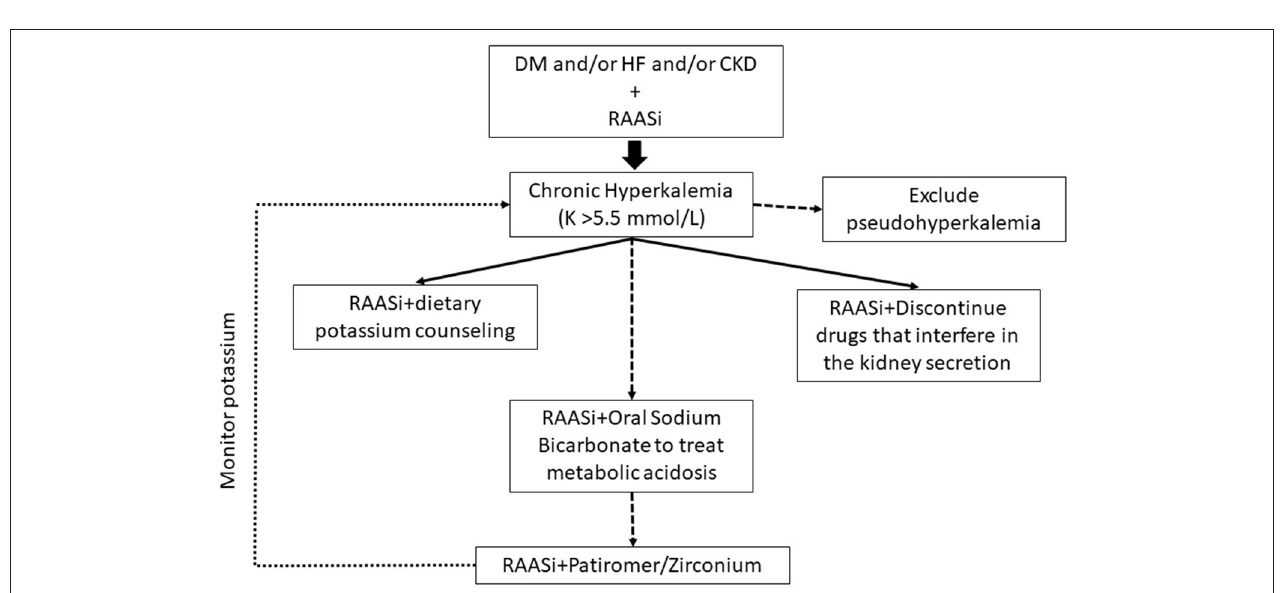
FIGURE 3 | Treatment algorithm for chronic hyperkalemia. Current recommendations regarding the management of chronic hyperkalemia (long-term elevated serum potassium) include the management of diuretics, modification of RAASi dose, treatment of metabolic acidosis with sodium bicarbonate, and removal of other hyperkalemia-causing medications. A team approach for chronic hyperkalemia, primary care physicians, nurses, pharmacists, or dietitians is optimal. The initiation of potassium binding agents should be considered in patients with chronic hyperkalemia despite optimized diuretic therapy and correction of metabolic acidosis. CKD, chronic kidney disease; DM, Diabetes Mellitus; HF, hearth failure; K, potassium; RAASi, renin-angiotensin-aldosterone system inhibitors.